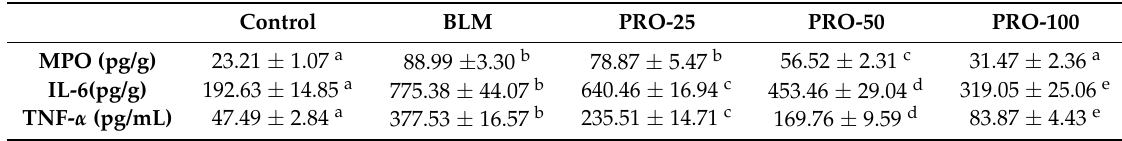
Table 2. Effect of the PRO on the inflammatory markers in lung tissue homogenate of BLM-treated mice. Control